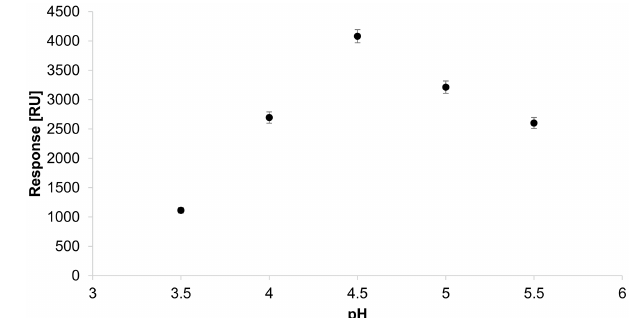
Figure 1. li SPR system responses of the electrostatically adsorbed streptavidin molecules vs. pH. The data represent mean values of 1280 monitored spots across a (9 × 0.8)mm 2 measuring area; error bars indicate the corresponding standard